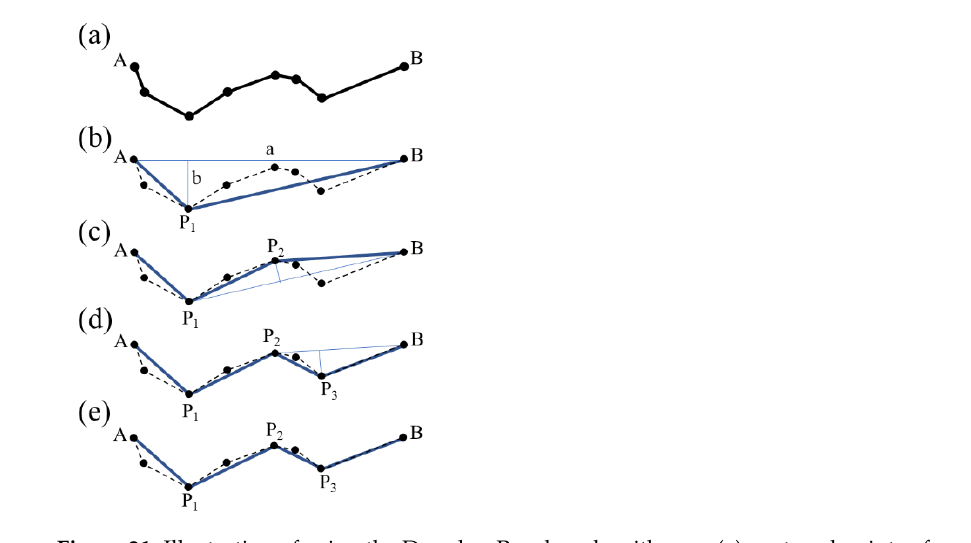
Figure 21. Illustration of using the Douglas–Peucker algorithm on ( a ) captured points of an object’s edge contour curve, and progression to find P 1 , P 2 , and P 3 edge points in ( b – d ), respectively, to form ( e ) final polyline showing three vertices of the contour.